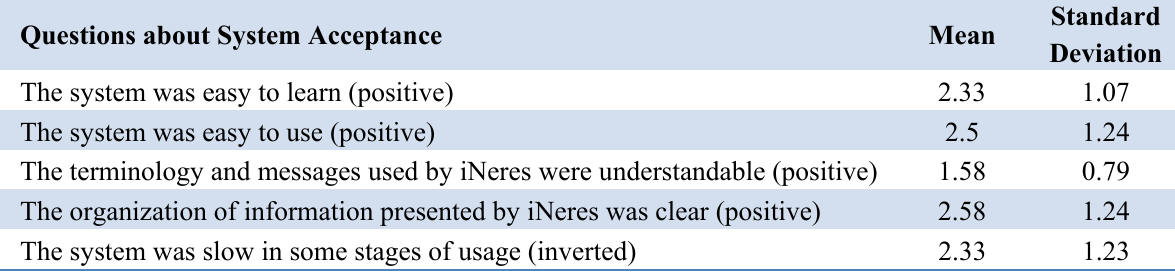
Table 3. Statements, mean and standard deviation for the second part of the